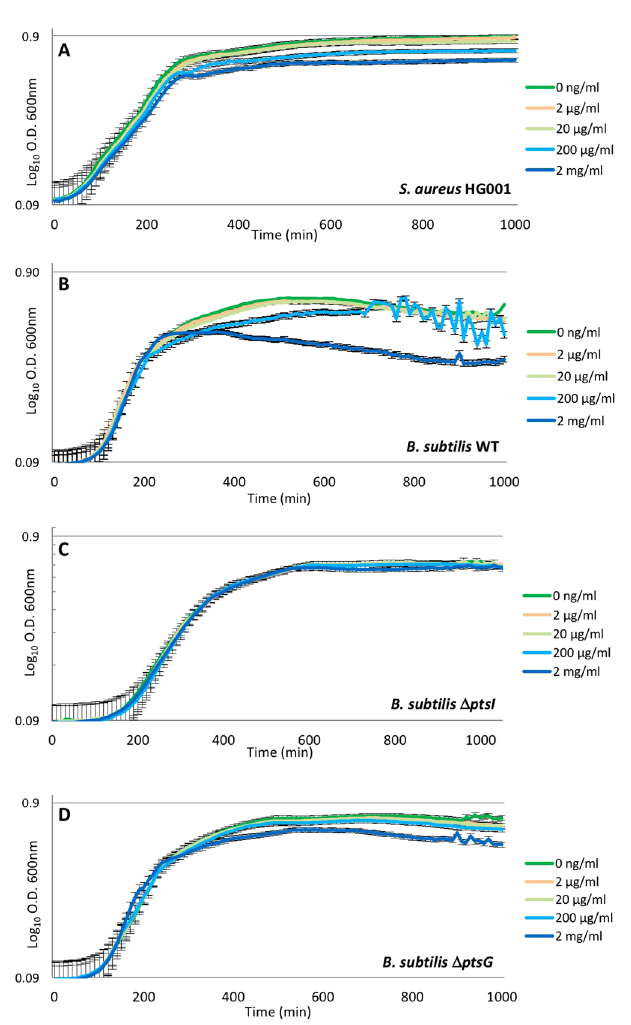
Figure 4. Growth of S . aureus and B . subtilis in the presence of non-labeled FDG. S . aureus HG001 was grown in TSB ( A ), and the B . subtilis strains 168 (WT), Δ ptsI and Δ ptsG were grown in LB ( B , C and D ) with increasing concentrations of non-radiolabeled FDG as indicated in color code. OD 600 readings were recorded every 10